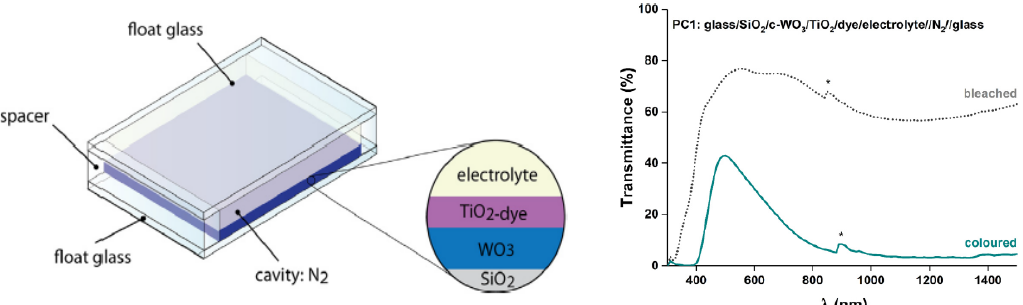
Figure 7. Schematic representation of the single glass photochromic demonstrator (Left); Transmittance spectra of a demonstrator in the bleached and colored state (Right). (* denotes an effect of monochromator change). Reprinted from Solar Energy Materials and Solar Cells, Volume 186, M. Hocevar et al., A photochromic single glass pane, Pages 111–114, Copyright (2018), with permission from Elsevier.